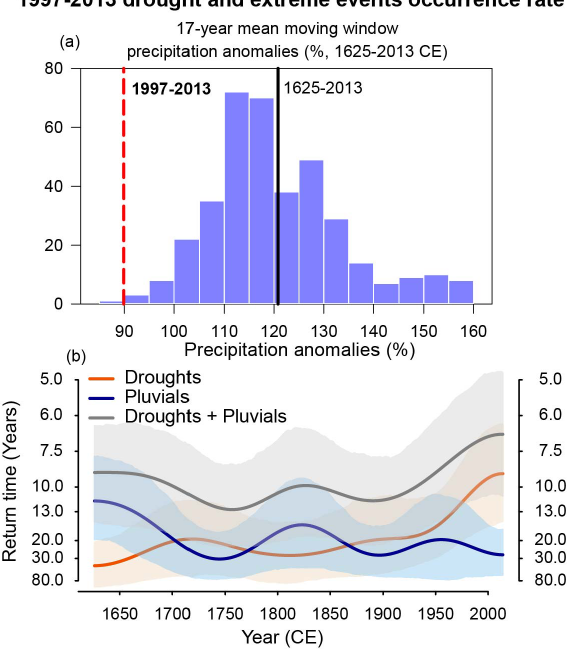
Figure 4. The 1997–2013 drought and extreme precipitation event occurrence rates. (a) Average reconstructed precipitation for the pe- riod 1997–2013 (dashed red line) and for the period 1625–2013 (black line) compared to 17-year-average moving-window precip- itation anomaly distribution (%) for the reconstructed period 1625– 2013. (b) Occurrence rate of extreme dry (orange) and wet (blue) precipitation events and the sum of both (dry plus wet; gray) for the period 1625–2013. Extreme dry/wet events were calculated for the 5th and 95th percentile thresholds of the precipitation reconstruc- tion, respectively. A smoothed bandwidth of 40 years was applied using a time-dependent kernel method. The shaded areas represent 95% confidence intervals based on 1000 bootstrap